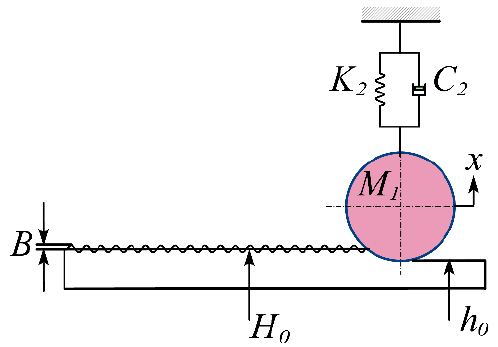
Figure 12. Vibration mechanics model with strip thickness fluctuation.